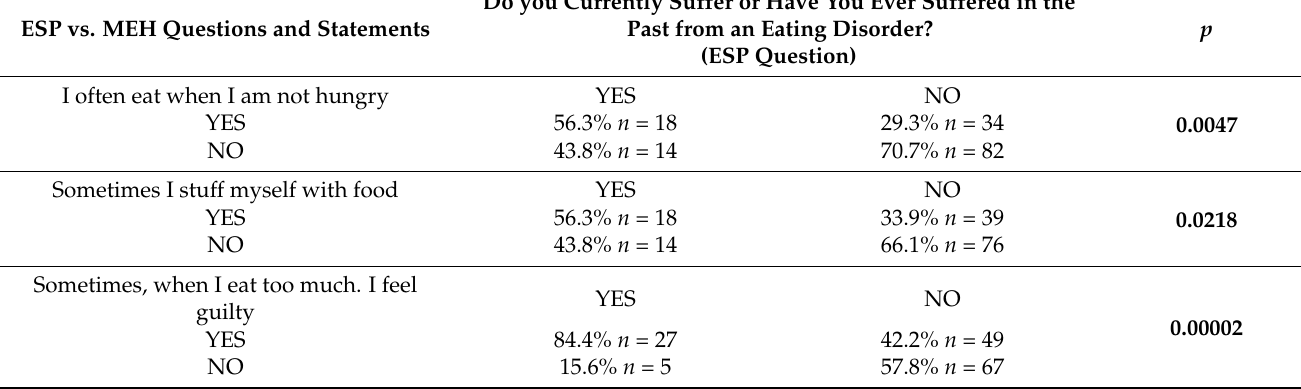
Table 14. The distribution of responses to selected statements from the My Eating Habits questionnaire in accordance with behaviors typical for people with compulsive overeating syndrome in